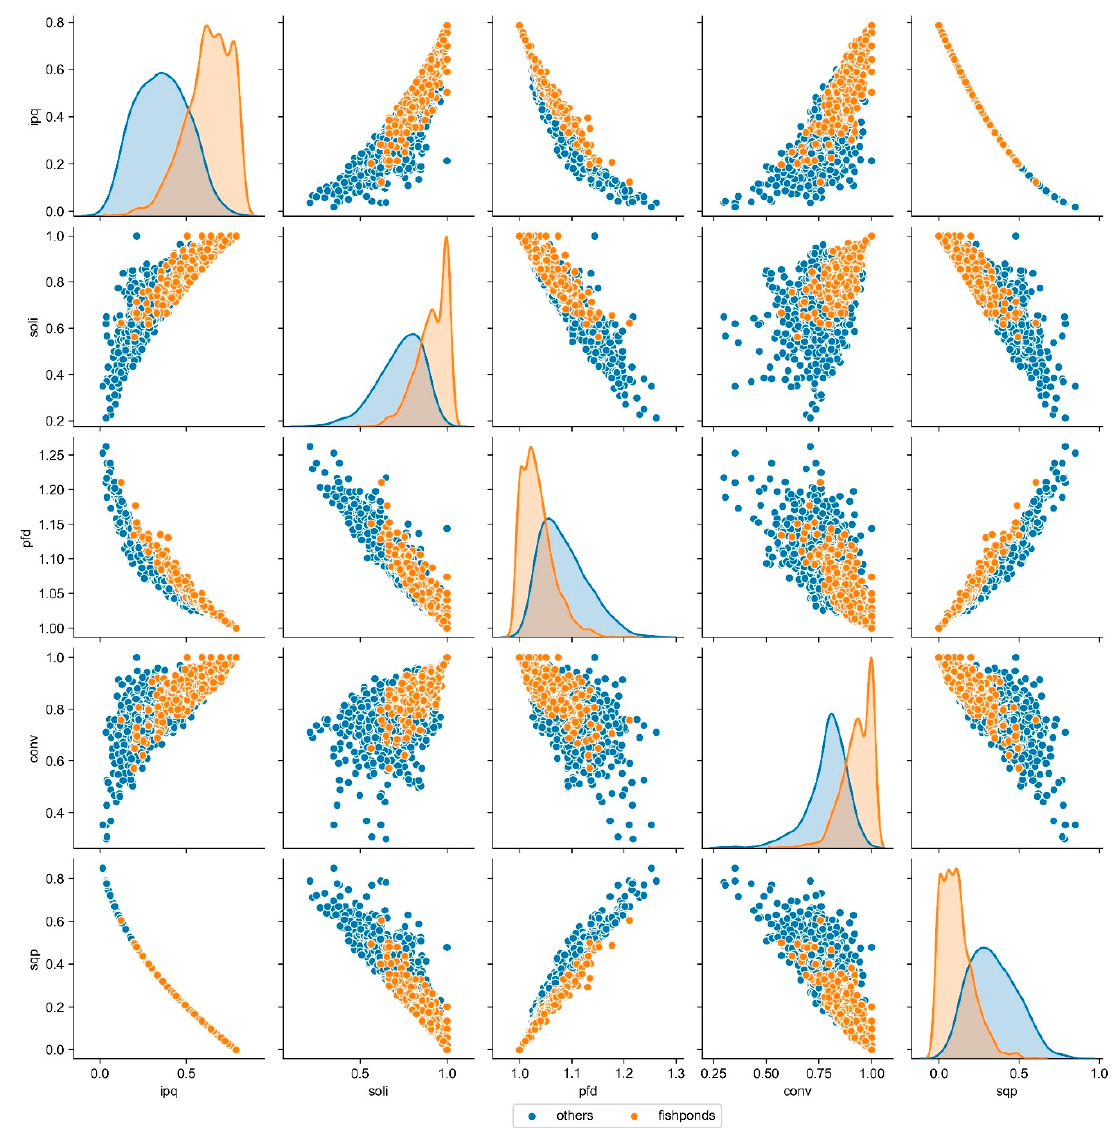
Figure 10. Paired scatter plots of OBFs. Diagonal plots are histograms of each OBF for fishpond and non-fishpond classes. Off-diagonal plots are scatter plots of corresponding feature pairs of fishponds and non-fishponds samples.